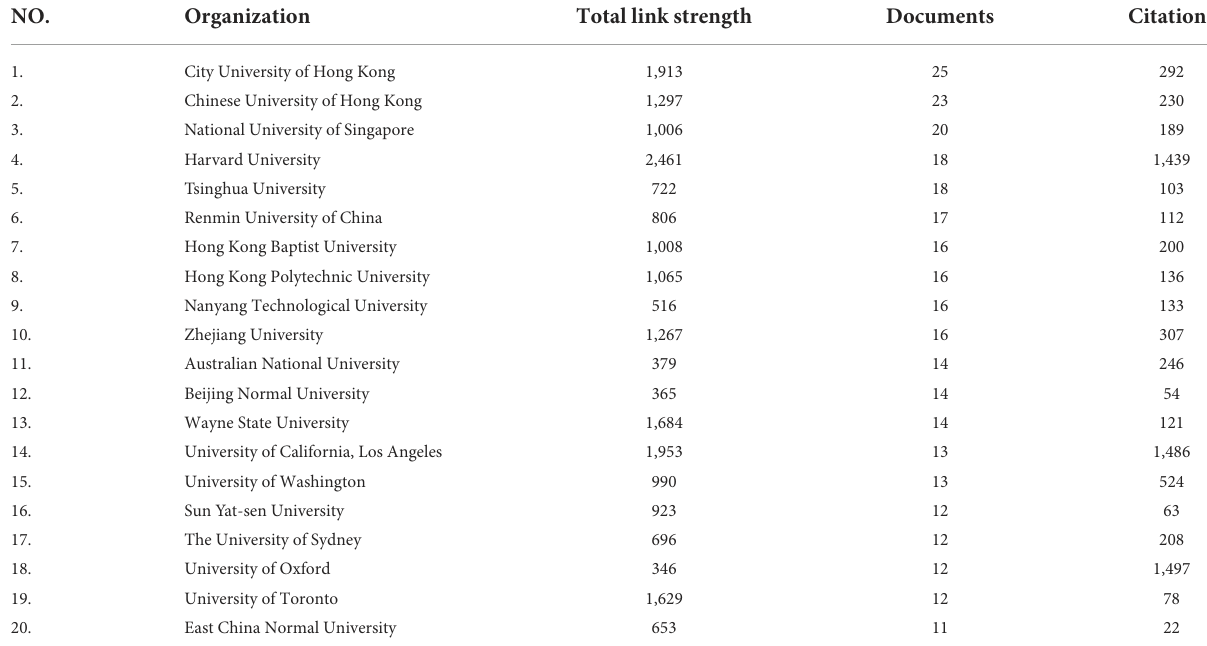
TABLE 3 Bibliographic coupling by